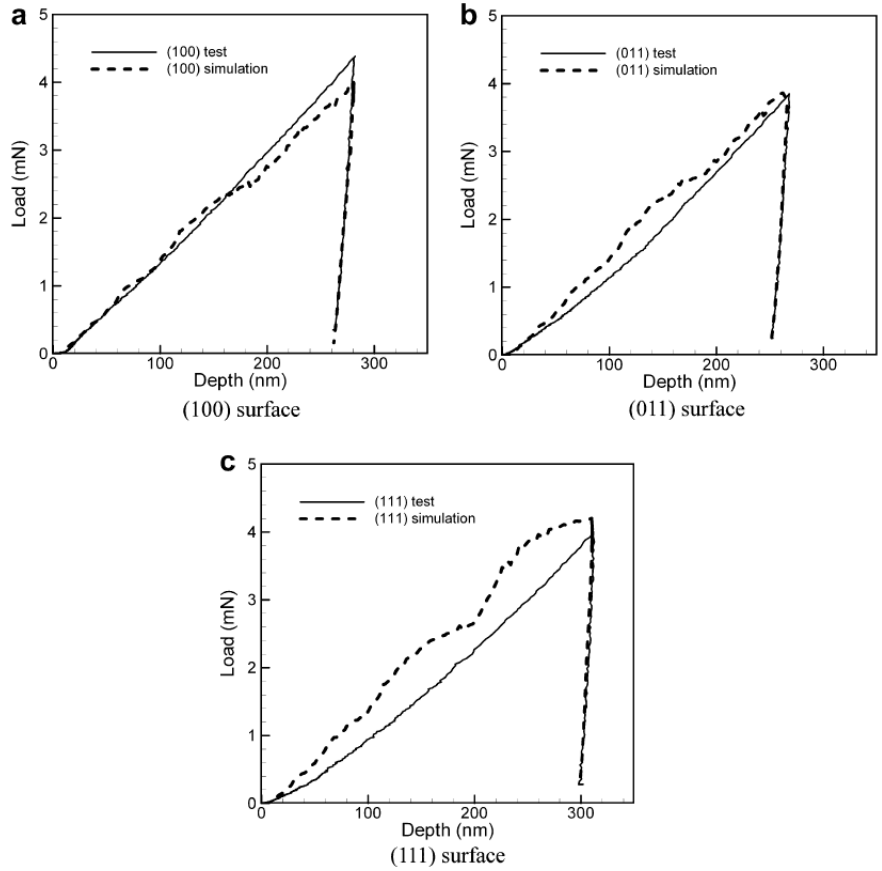
Figure 36. Comparisons between numerical and experimental load-displacement curves on copper samples of different crystallographic orientations made with a spherical indenter (tip radius 3.4 µ m): ( a ) (100) plane; ( b ) (011) plane and ( c ) (111) plane [133]. Reproduced with permission from Y. Liu et